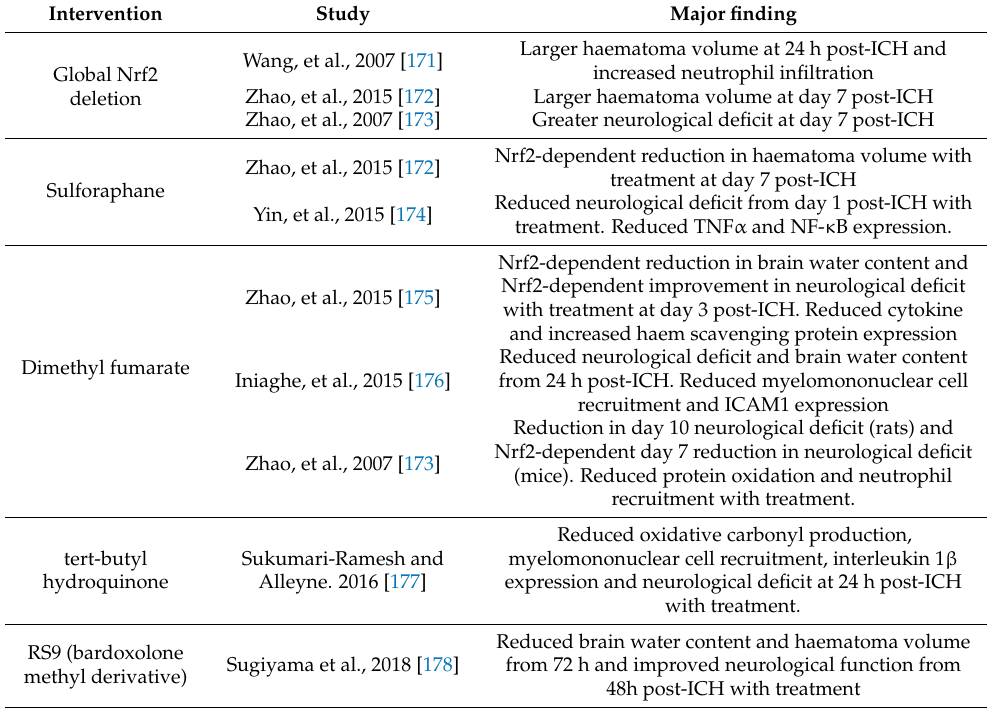
Table 2. Key in vivo studies of Nrf2 pathway modulation after